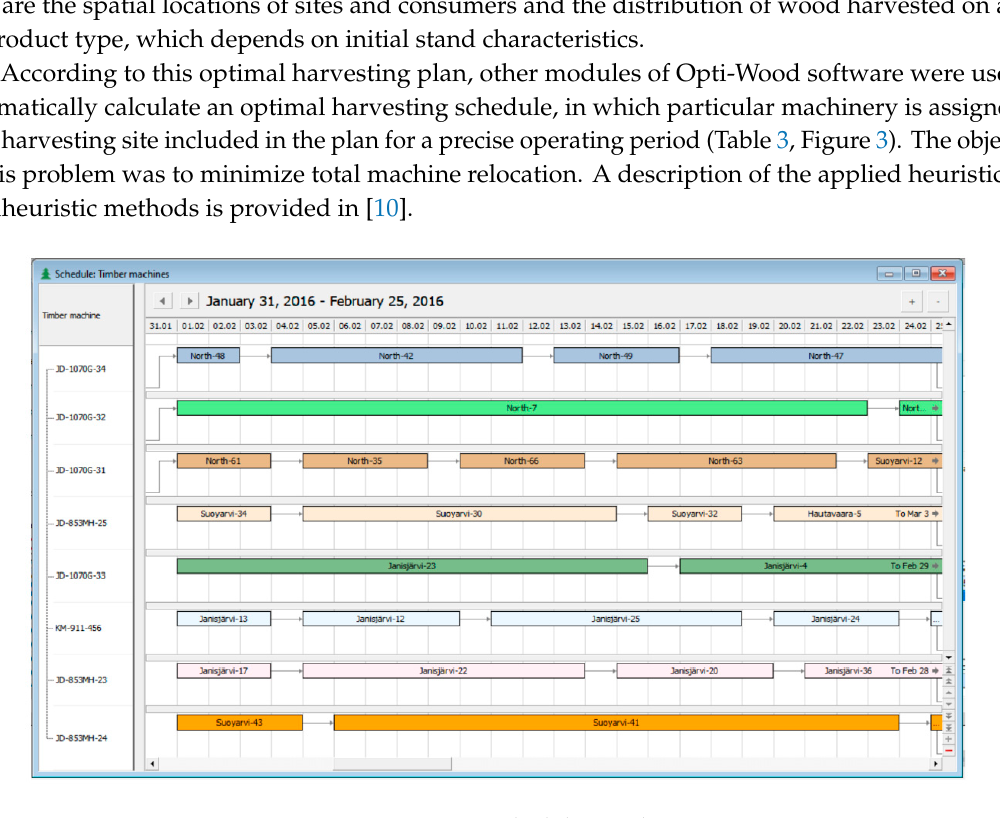
Figure 3. Harvesting schedule visualization.